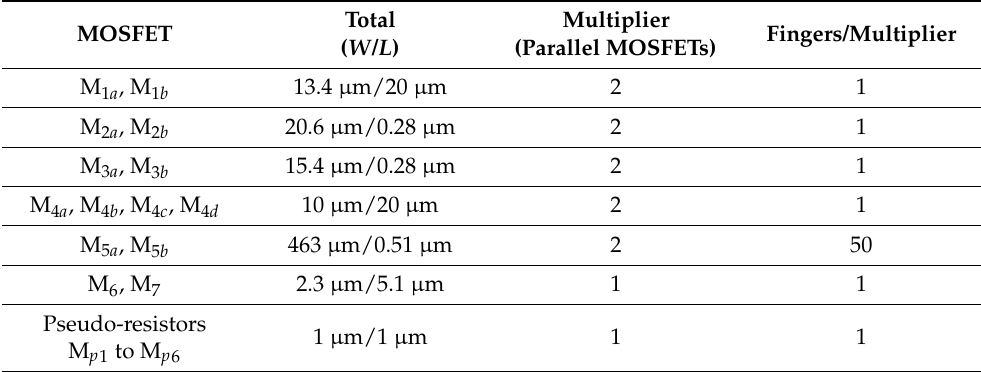
Table 1. Dimensions of the MOSFETs that comprises the OTA and the pseudo resistors. MOSFET